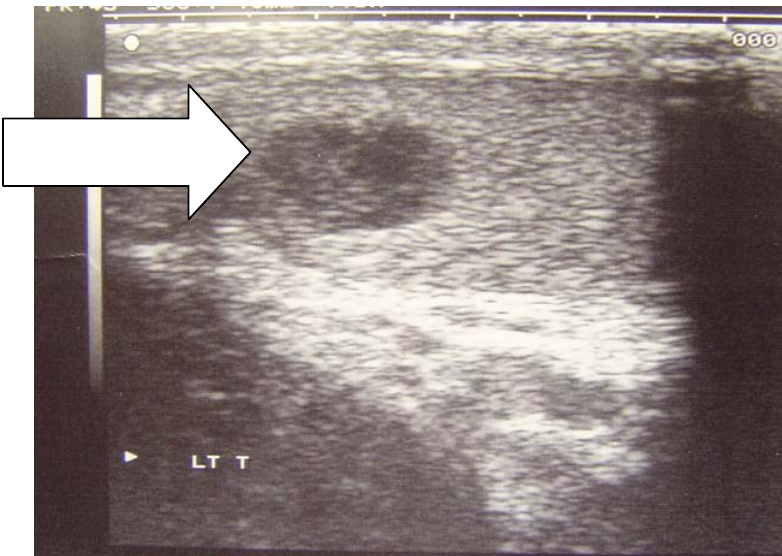
FIGURE 1 . Left testicular USS showing a 12-mm hypoechoic